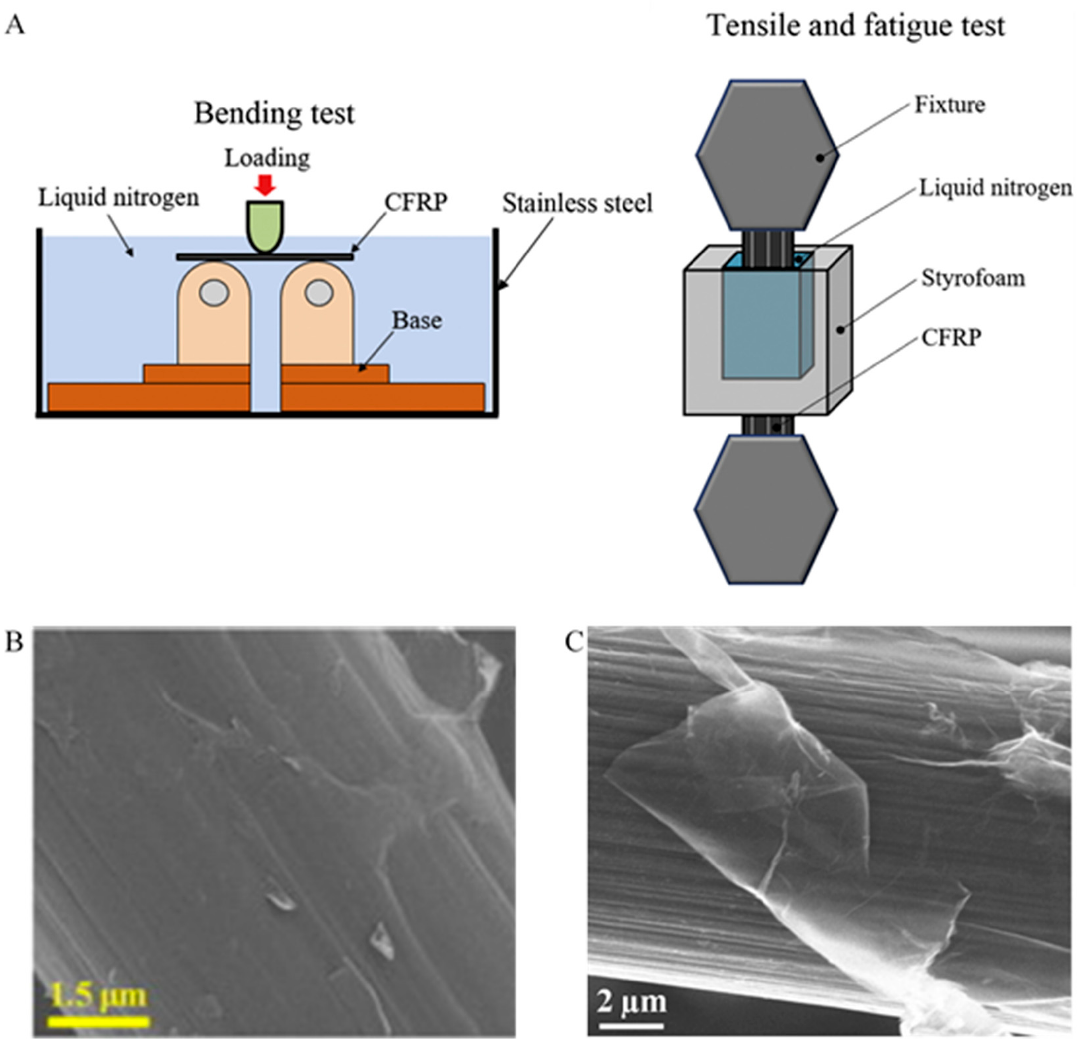
Figure 2. ( A ) Schematic diagrams of cryogenic testing system for three-point bending and tensile tests. Reprinted from ref. [106], Copyright 1969 Elsevier Ltd. ( B ) SEM image of GO coated SCFs. Reprinted with permission from ref. [105], Copy- right 2016 Elsevier Ltd. ( C ) SEM images of graphene oxide grafted on CF. Reprinted with permission from ref. [107],